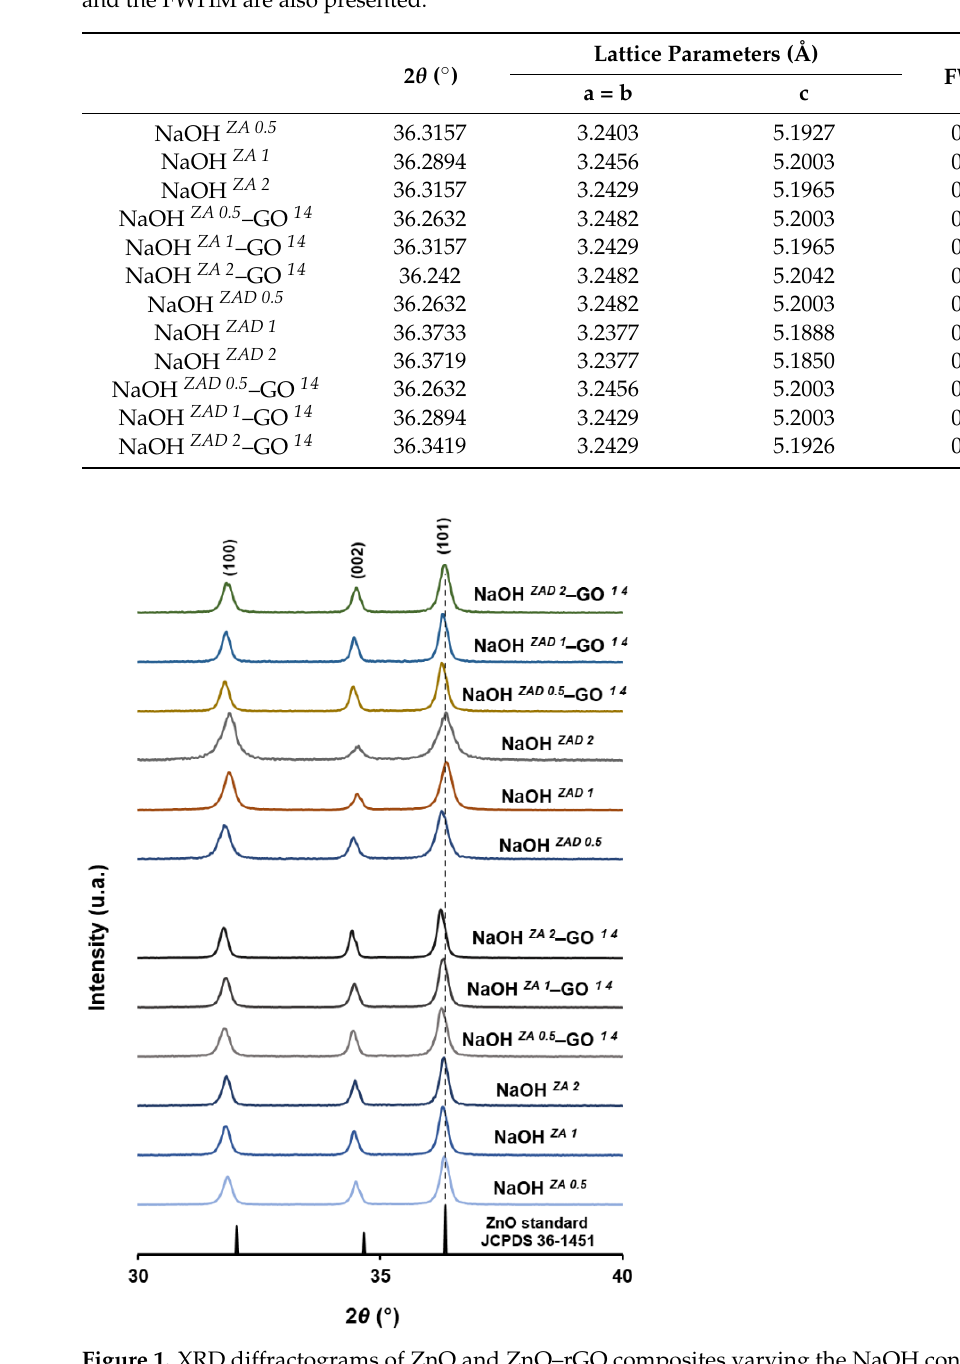
Figure 1. XRD diffractograms of ZnO and ZnO–rGO composites varying the NaOH concentration (0.5, 1, and 2 M) and the zinc precursor (ZA and ZAD).